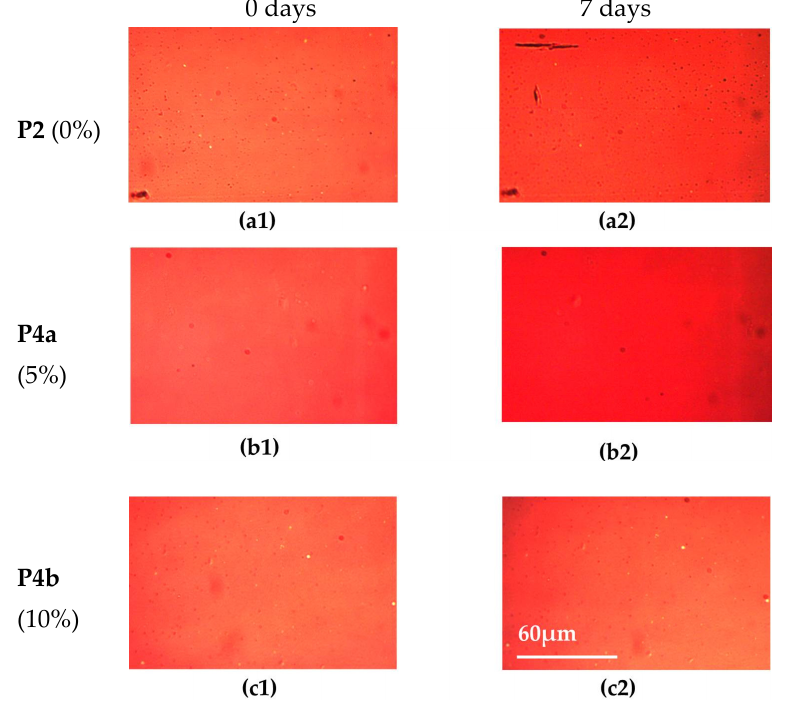
Figure 6. Optical microscope images (with 50× magnification) of the active layers of RC PSCs based on P2 ( a ), P4a ( b ) and P4b ( c ) after exposure to 85 °C for zero days (1) and seven days (2).